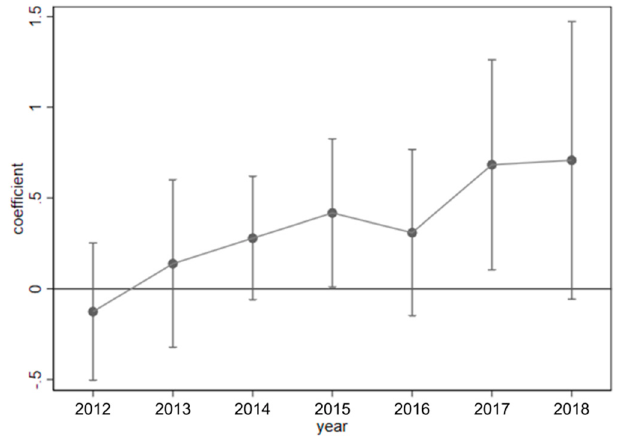
Figure 5. Parallel trend test.